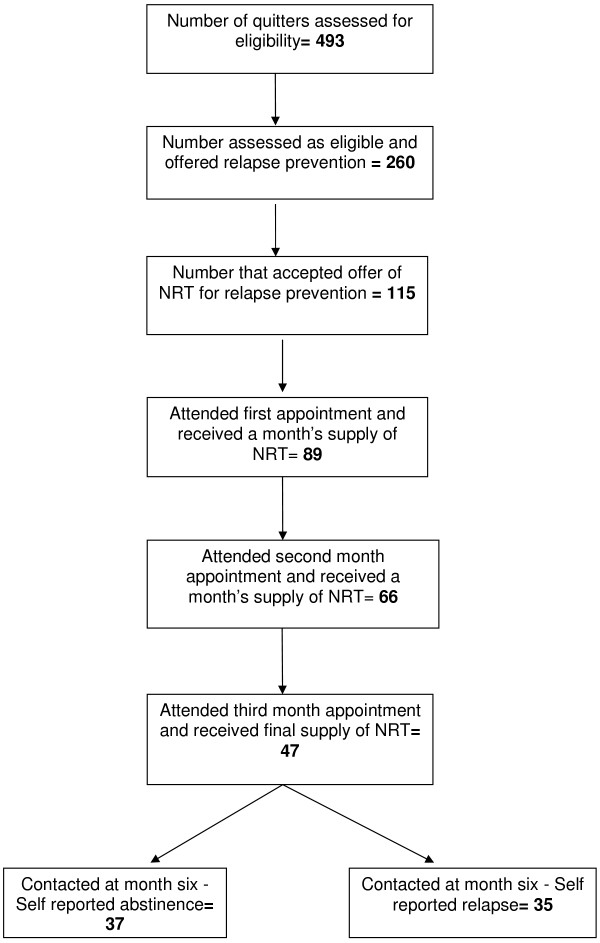
Study flow chart.